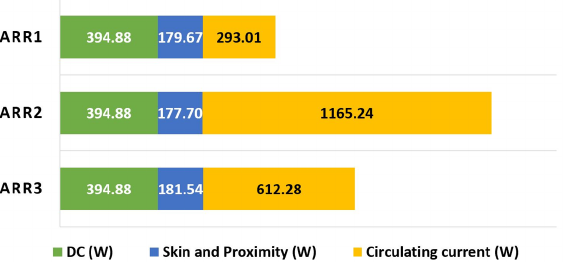
Figure 16. Segregation of losses in the winding into components for ARR1, ARR2 and